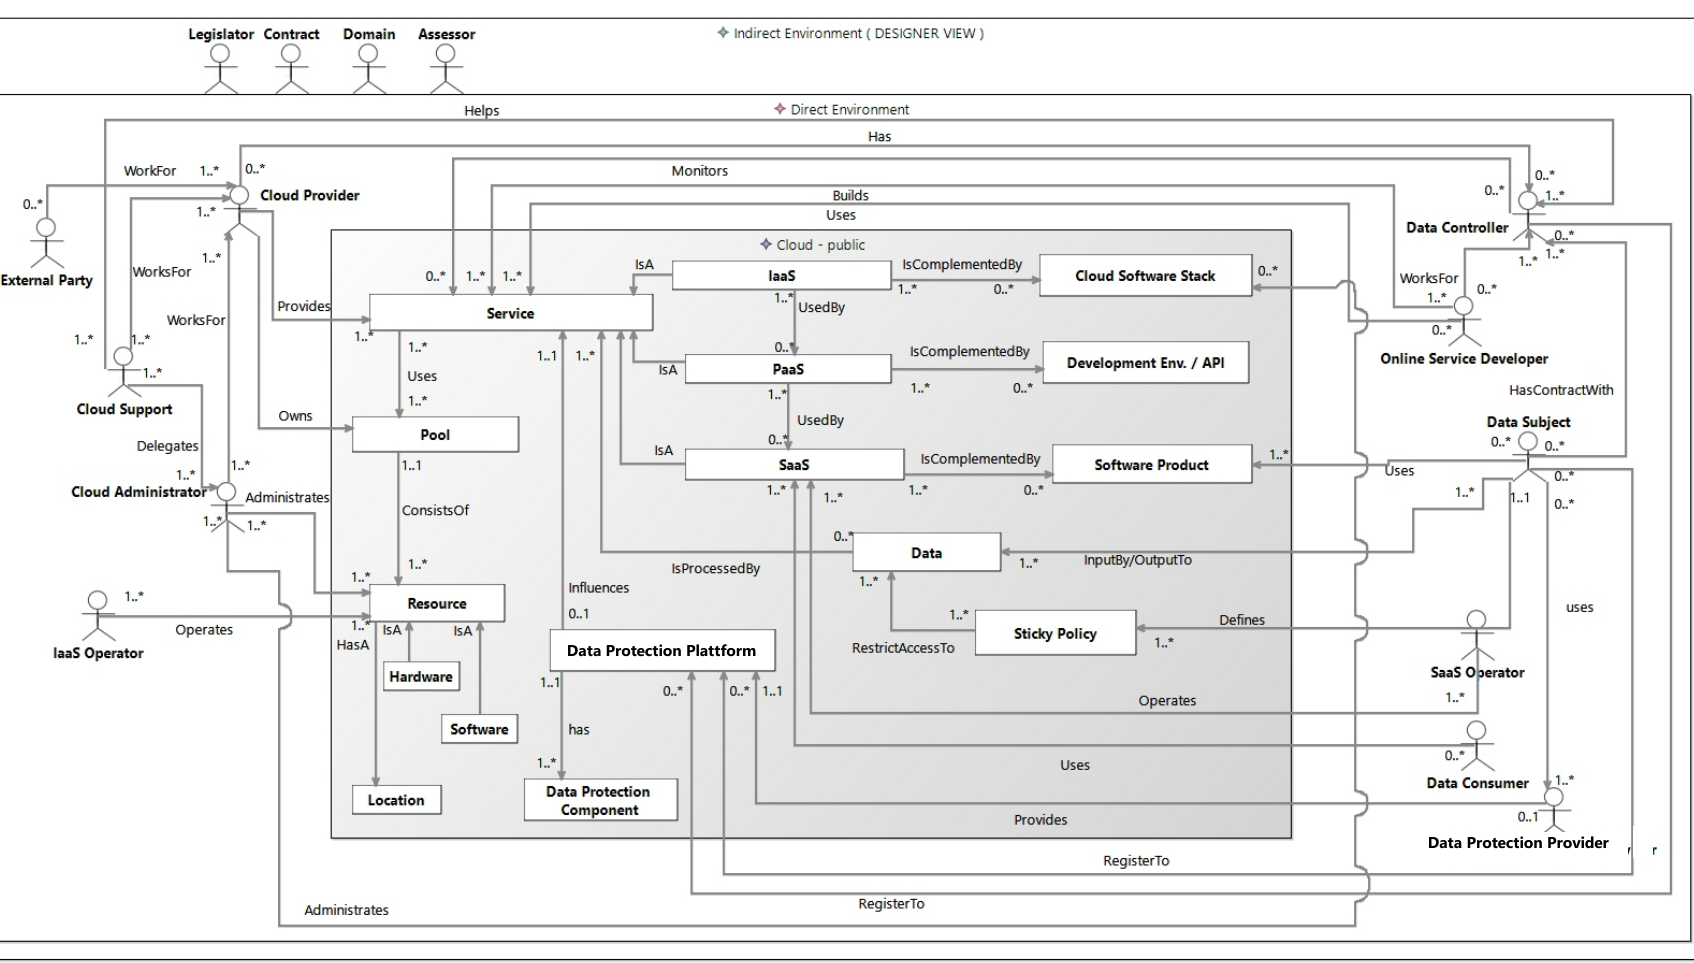
Figure 2. RestAssured-Cloud System Analysis